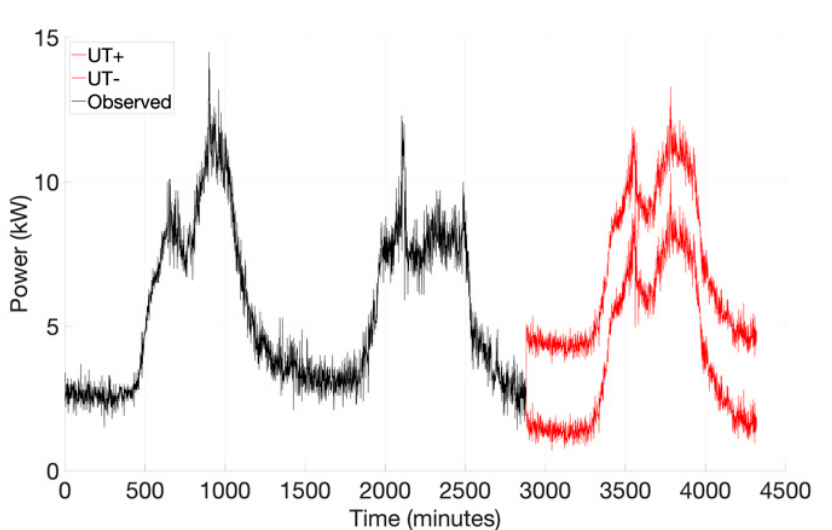
Figure 8. UT applied in home 1 demand.